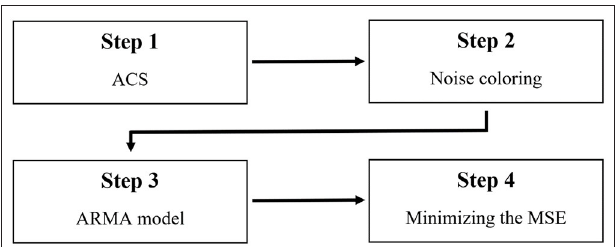
FIGURE 6 | Block diagram of the new algorithm for estimating the transfer function phase without the minimum phase assumption.